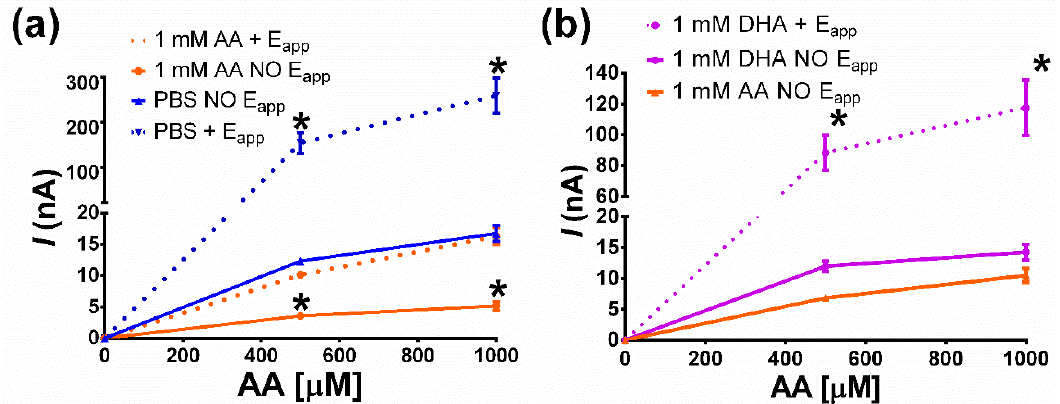
Figure 4. Ascorbic acid (AA) calibrations of sensors treated with Chemiplus 2DS HB (n = 4 for each experimental group) after 5 days of storage under di ff erent conditions: ( a ) treated electrodes stored in a 1 mM solution of ascorbic acid with an applied potential of + 700 mV vs. Ag / AgCl (1 mM AA + E app ), treated electrodes stored in a 1 mM solution of ascorbic acid without any potential (1 mM AA NO E app ), and treated electrodes stored in PBS solution without any potential (PBS NO E app ); ( b ) treated electrodes stored in a 1 mM solution of AA or dehydrodiascorbate (DHA) with an applied potential of + 700 mV vs. Ag / AgCl (1 mM DHA + E app ), treated electrodes stored in a 1 mM solution of DHA without any potential (1 mM DHA NO E app ), and treated electrodes stored in a 1 mM solution of ascorbic acid without any potential (1 mM AA NO E app ). A * means a statistically significant di ff erence ( p < 0.05) between registered currents.